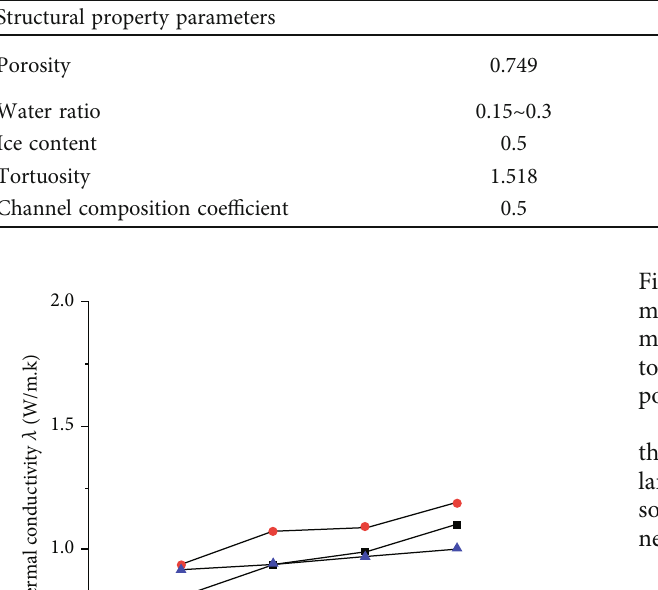
Table 1: Experimental parameters.